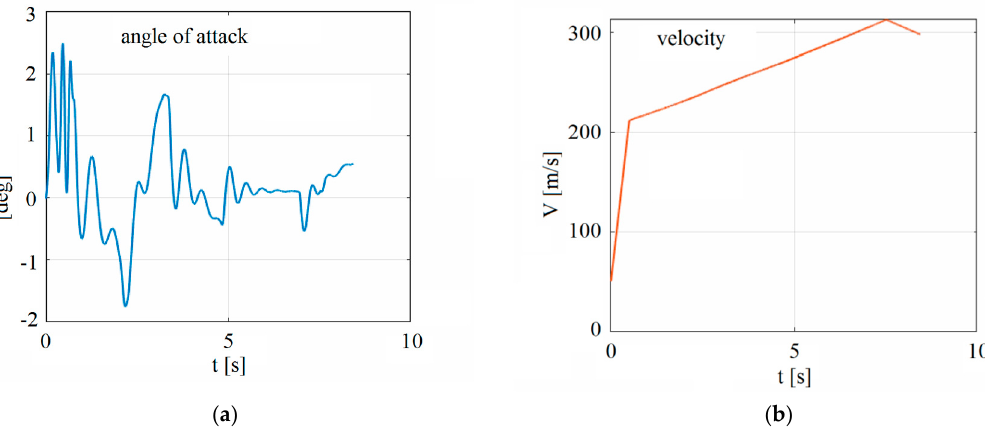
Figure 18. Implemented angle of attack α ( a ) and velocity of the ATGM ( b ) in function of time.